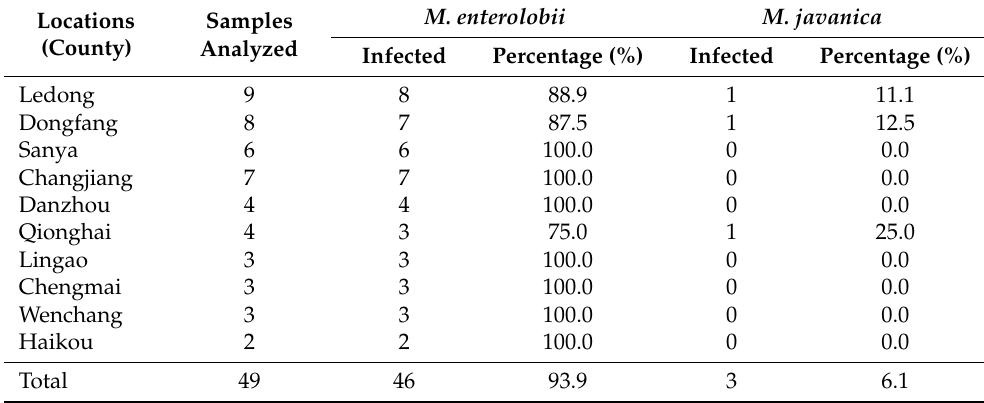
Table 3. Distribution of root-knot nematode species on red dragon fruit plants in different counties in